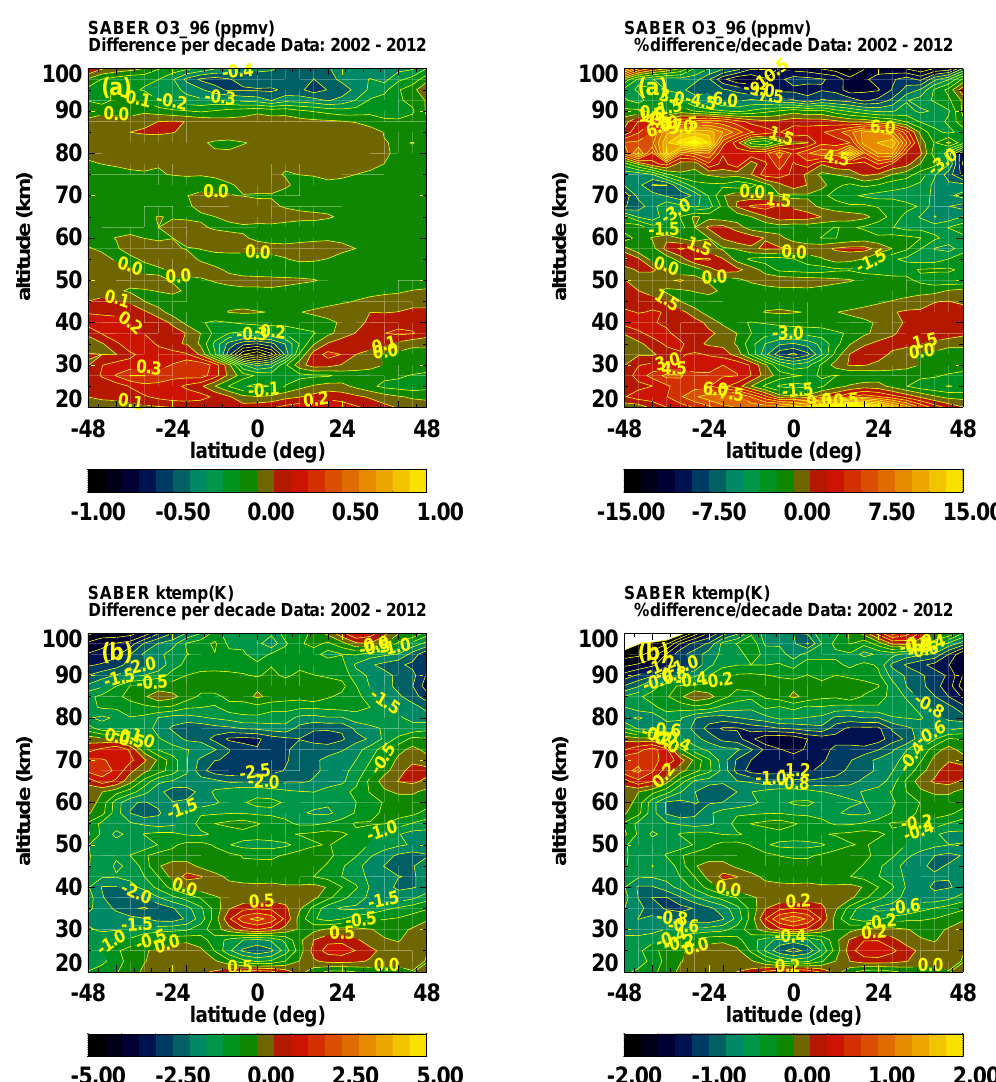
Figure 2. Ozone and temperature trends on altitude (20 to 100km) vs. latitude (48 ◦ S to 48 ◦ N) coordinates. Top row left: ozone differences (ppmv) (2012–2002); right: percent differences. Bottom row: as in top row, but for temperature (K). Brown-green borders denote zero contours, with brown and red areas denoting positive